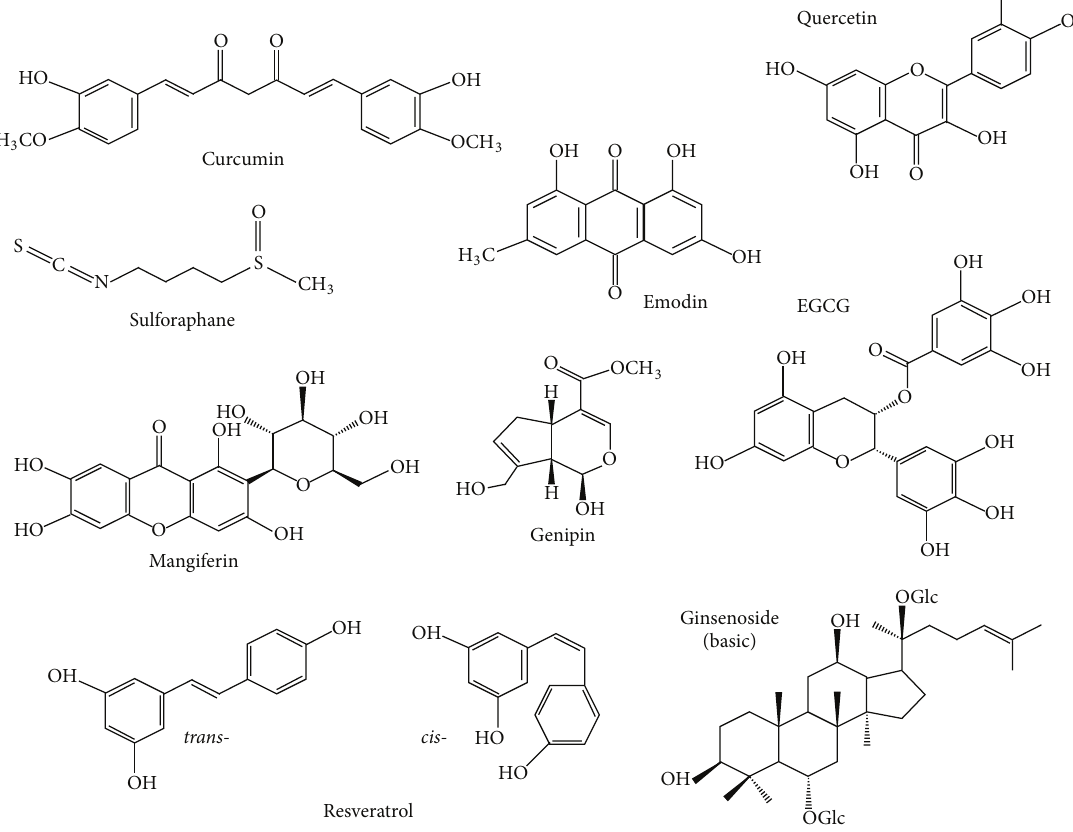
Figure 2: Chemical structure of natural compounds influencing NLRP3 inflammasome